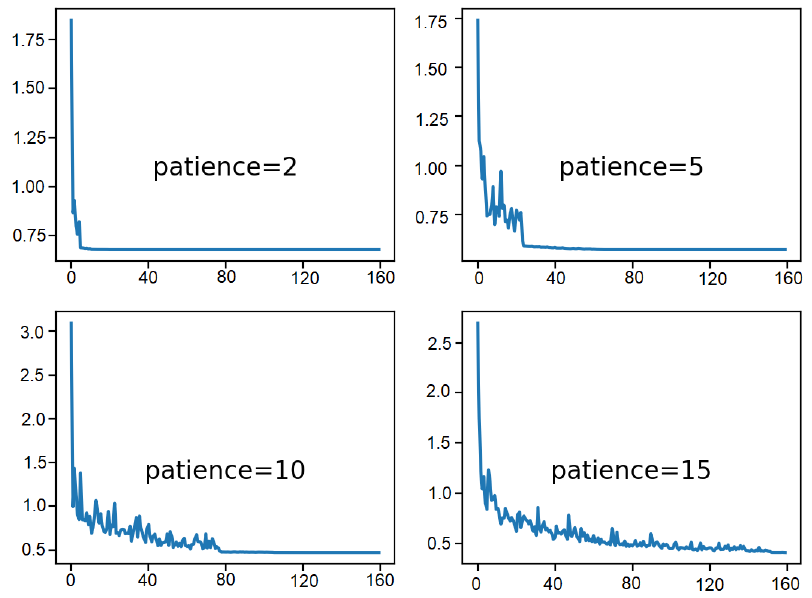
Figure 15. Result analysis of various patience values: training accuracy over